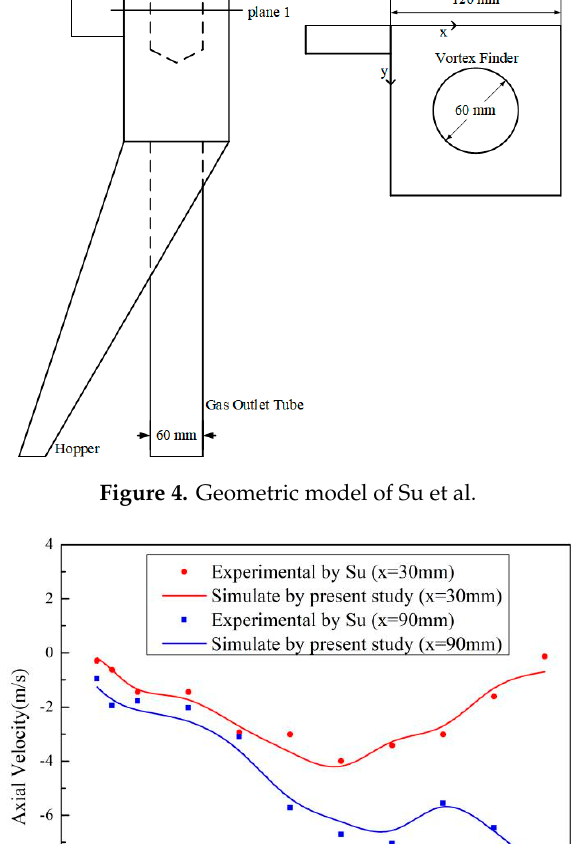
Figure 5. Comparison of simulated velocity with measurements.